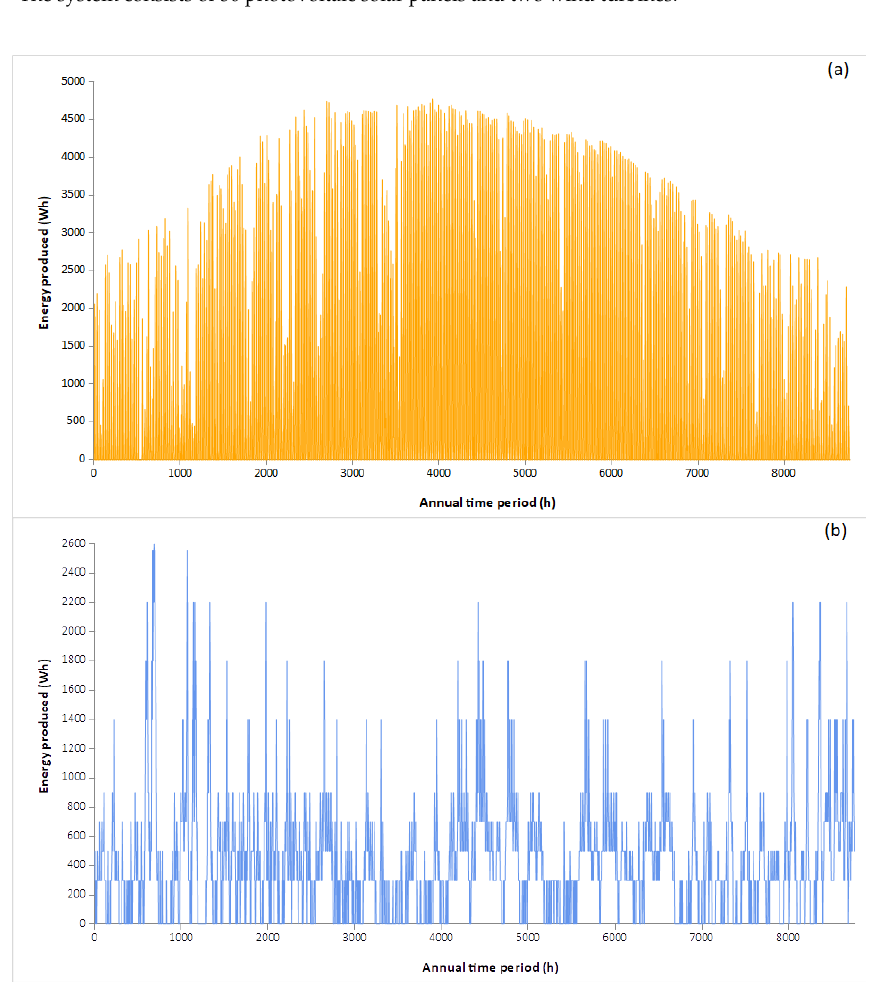
Table 4. Average monthly solar and wind resource for energy production of the optimal system 1 . Month Gh (W/m 2 ) Ws (m/s) PV (Wh) WT (Wh)